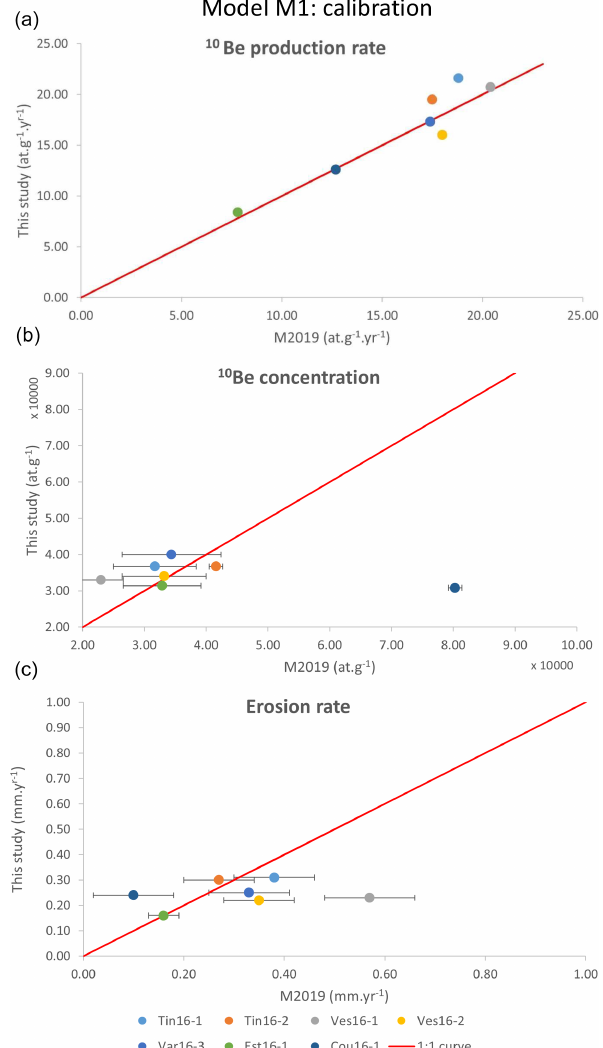
Figure 4. Comparison between the results of Mariotti et al. (2019) ( x axis) and the short-term model (this study, y axis) for several rivers of the Var catchment for 10 Be production rates (a) , 10 Be con- centration in river sediments (b) and steady-state erosion rates (c) . Red line indicates the 1 : 1 slope. See Table 2 for